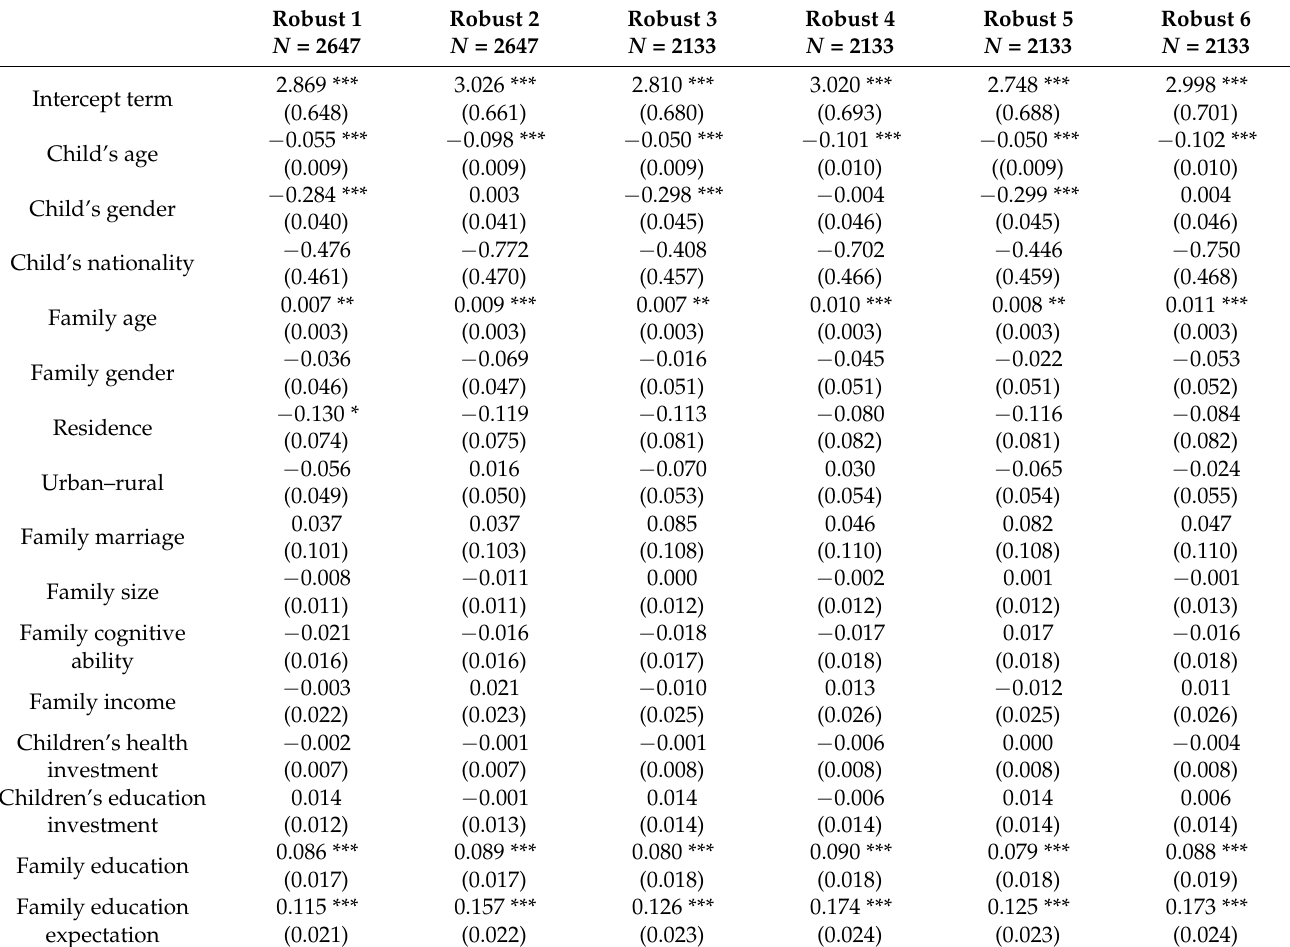
Table A1. Results for robustness